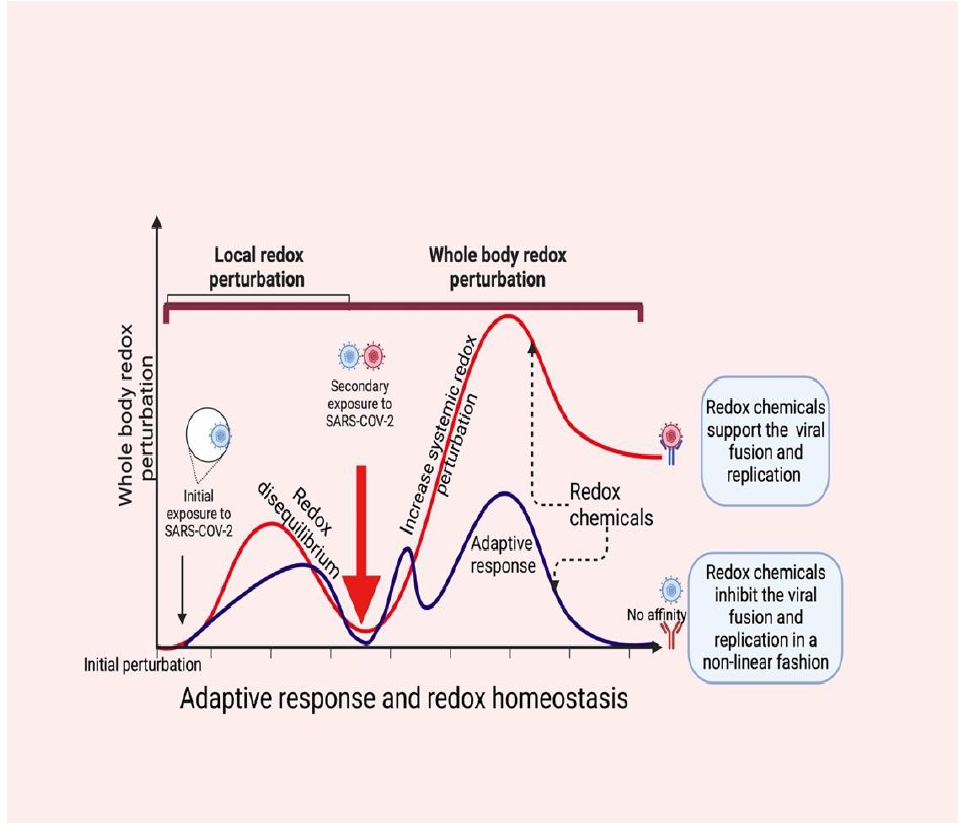
Figure 3. SARS-CoV-2 infection perturbs redox homeostasis in supporting viral fusion and replication (red color). Local redox disequilibrium causes systemic redox disequilibrium, which favors the entry of SARS-CoV-2 and consequent viral loads (secondary exposure). Redox molecules act as redox codes for proper redox communication, which induces an adaptive response by causing redox equilibrium in the host (blue color). This supports viral